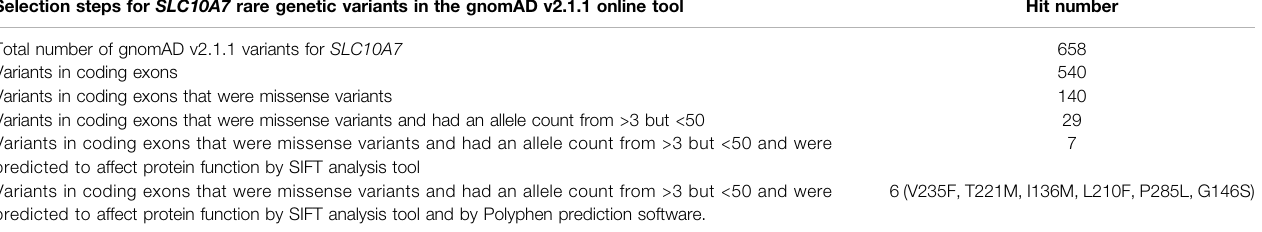
TABLE 3 | GnomAD selection algorithm for the selection of SLC10A7 rare genetic variants. Selection steps for SLC10A7 rare genetic variants in the gnomAD v2.1.1 online tool